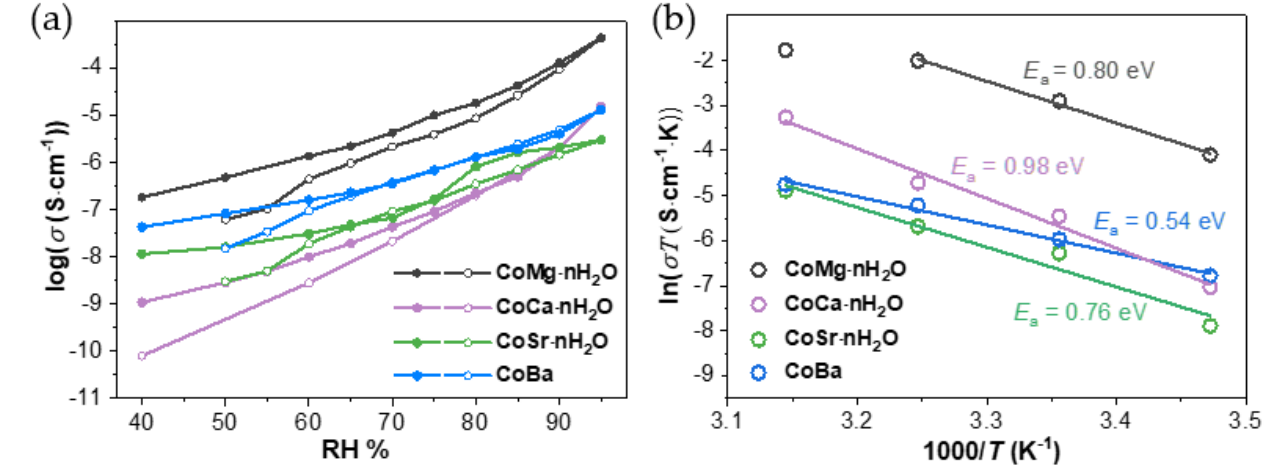
Figure 6. Proton-conductive properties of CoMg·nH 2 O , CoSr·nH 2 O , and CoBa ; ( a ) plots of log( σ ) vs. RH at 25 ◦ C (increasing RH: filled circle; decreasing RH: open circle). ( b ) Plots of ln( σ T ) vs. 1000/ T at 95% RH. The data of CoCa·nH 2 O are taken from Ref. 15.